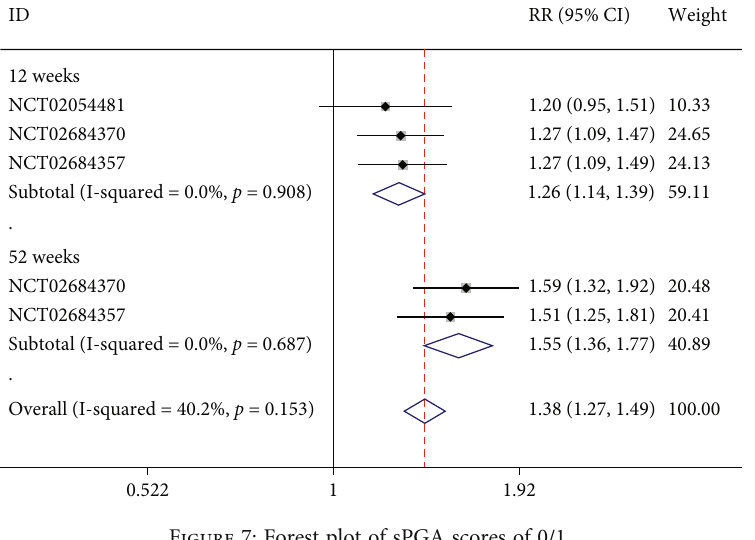
Figure 7: Forest plot of sPGA scores of 0/1.